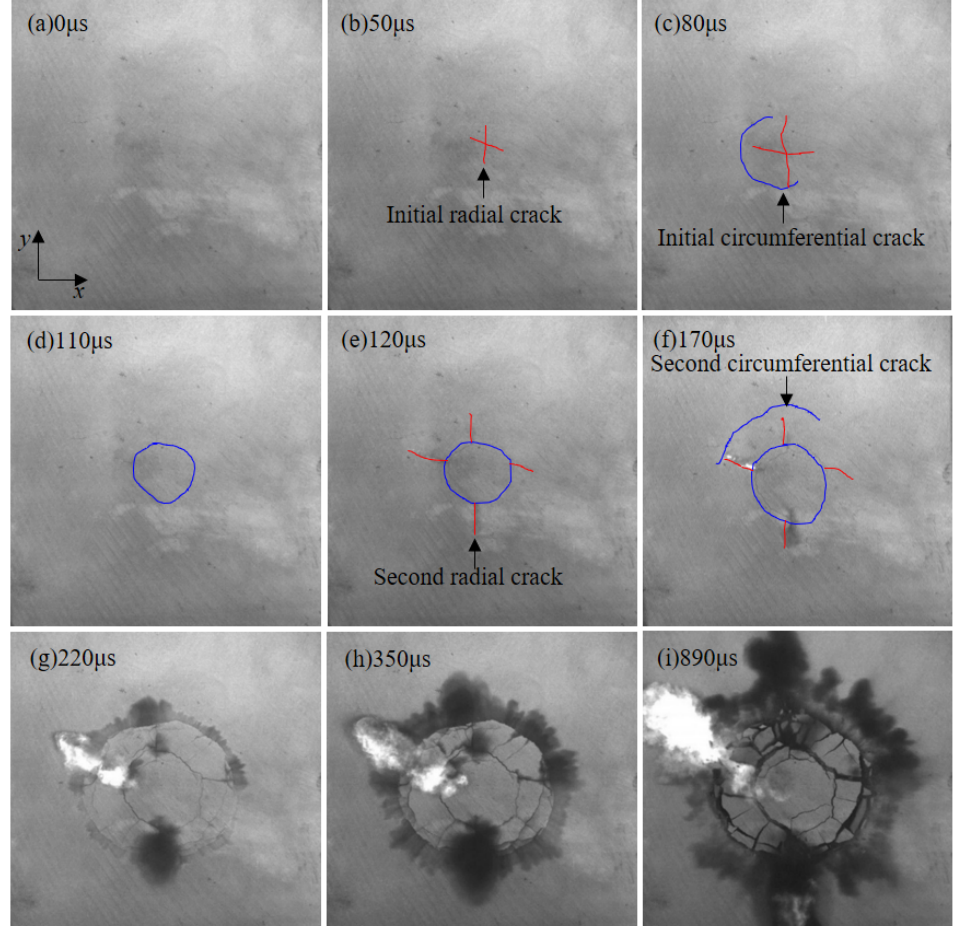
Figure 3. The crack network at different times during crater blasting under conditions without static stress. ( a – i ) The crack network after 0, 50, 80, 110, 120, 170, 220, 350, and 890 μs of explosion, respectively. At 110 μs, the circumferential crack was completely formed (see Figure 3d). At 120 μs, during the formation of the first circumferential crack, the first observed radial cracks continued to propagate outward, which are defined as the second radial cracks (see Figure 3e). At 170 μs, a second circumferential crack appeared above the blast hole, and a small amount of blasting dust began to escape (see Figure 3f). At 220 μs, the main radial cracks and circumferential cracks were completely formed and the second circumferential crack was the boundary of the blasting crater. Over time, the blasting fragments moved outward, but new cracks no longer appeared. At 890 μs, a large amount of blasting dust was emitted, and the strong light generated by the electrical explosion was visible. 3.2. Evolution of the Crack Network under an SSR of 0.1 Figure 4 shows the initiation and propagation process of the crack network on the free surface during crater blasting under an SSR of 0.1. In Figure 4b, under the coupled dynamic and static loads, four radial cracks were observed first at the centre of the blast hole at 60 μs. At 110 μs, the initial circumferential crack appeared on the upper right side of the blast hole (see Figure 4c). At 140 μs, the first circumferential crack was completely formed and the secondary radial cracks could be observed outside the initial circumferential crack (see Figure 4d). At 150 μs, the second circumferential crack appeared on the left of the blast hole (see Figure 4e). At 270 μs, the main radial and circumferential